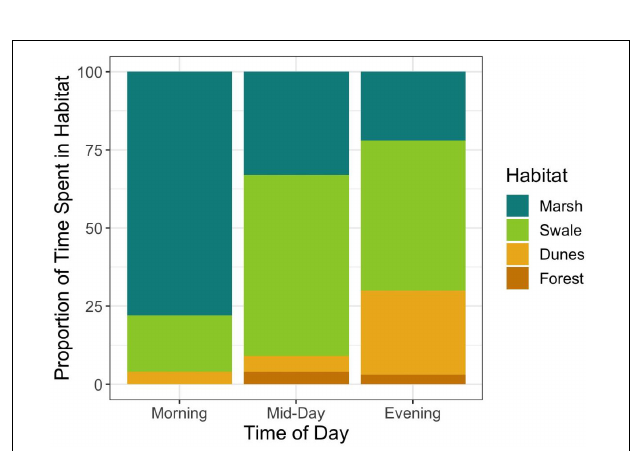
FIGURE 5 | Relationship between the proportion of horses sighted in each habitat during different periods of the day. The Shannon Diversity index increases as the day progresses, showing that horses are using habitats more evenly as wind speed increases (Morning = 0.27; Mid-Day = 0.42; and Evening =